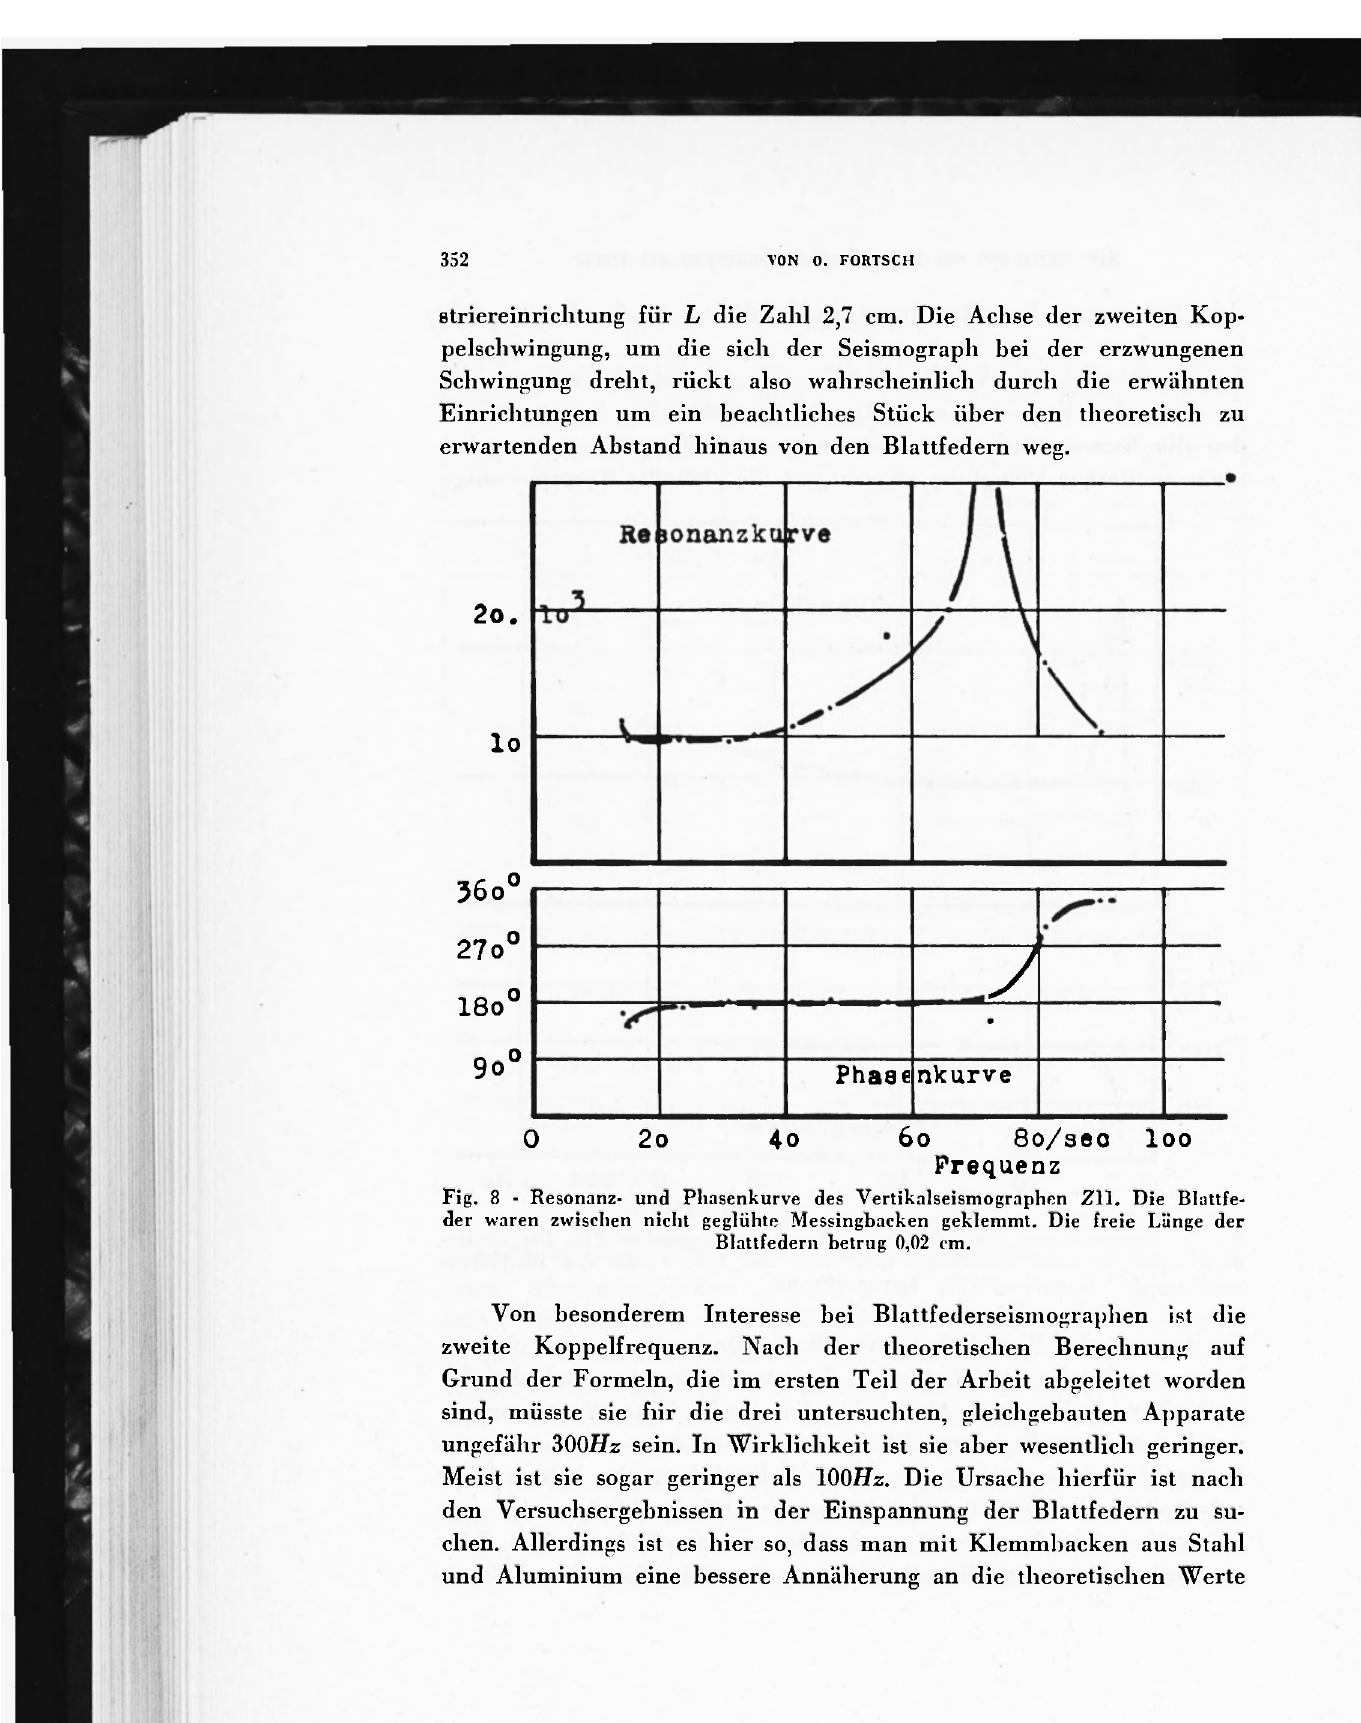
Fig. 8 - Resonanz- und Phasenkurve des Vertikalseismographen ZÌI. Die Blattfe- der waren zwisclien niclit gegliihte Messingbacken geklemmt. Die freie Liinge der Blattfedern betrug 0,02